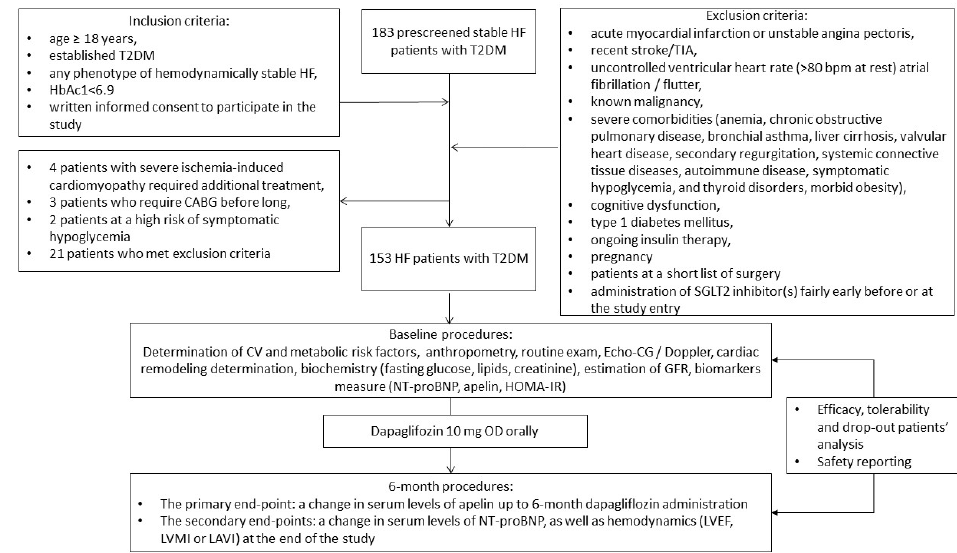
Figure 1. Flow chart of the study design. Abbreviations: T2DM, type 2 diabetes mellitus; CABG, coronary artery bypass grafting; TIA, transient ischemic attack; HF, heart failure; HOMA-IR, Homeostatic Assessment Model of Insulin Resistance